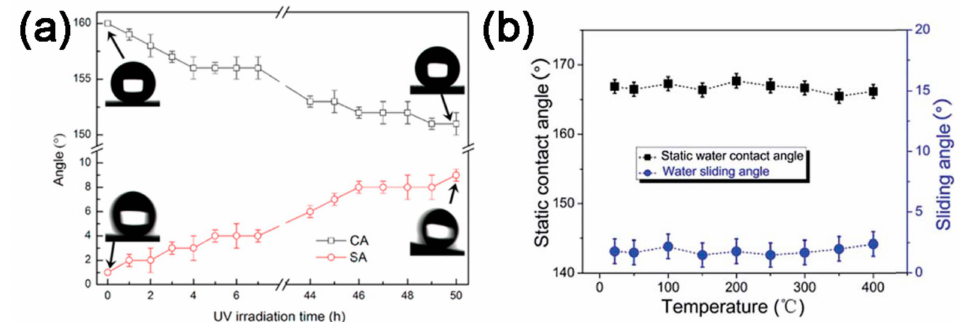
Figure 18. ( a ) WCAs and WSAs vary by di ff erent UV exposure time on super-hydrophobic steel. Reprinted (adapted) with permission from [86]. Copyright (2015) American Chemical Society; ( b ) The thermal stability of transparent porous silica coating. Reproduced with permission from [106]. Copyright (2015), with permission from Royal Society of